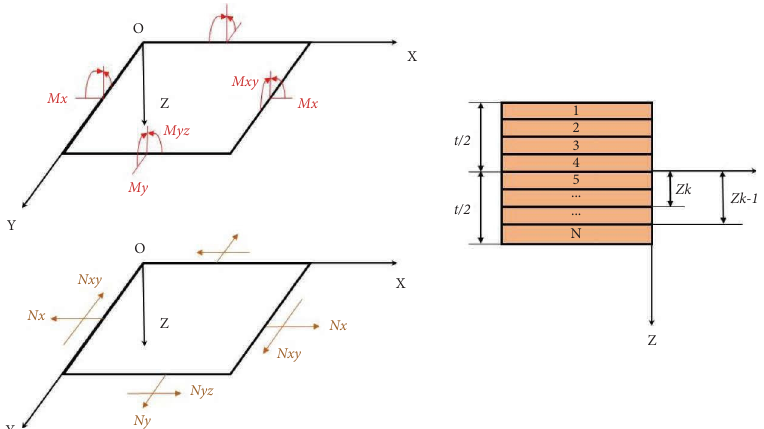
Figure 2: Structure and stress of classical